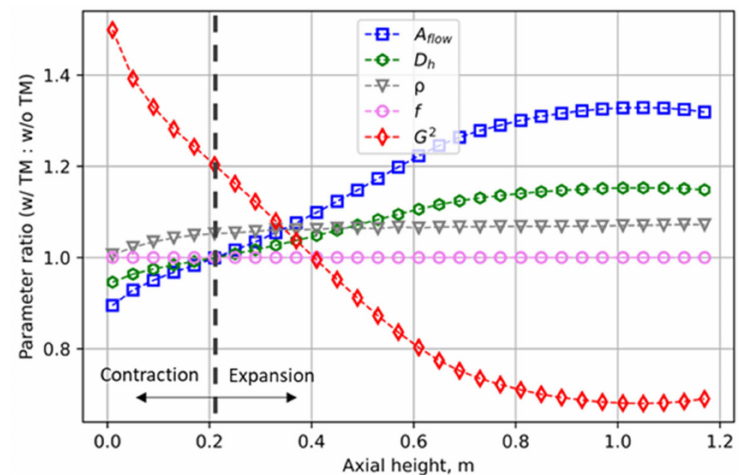
Figure 13. Comparison of hot channel pressure loss component